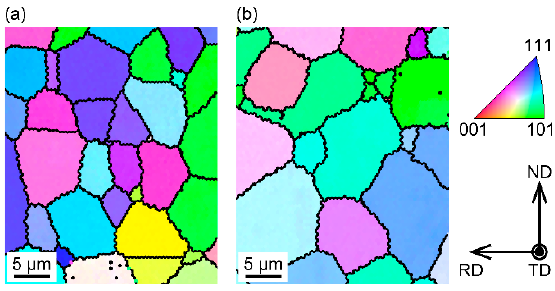
Figure 10. IPF maps of the chip specimens after heat treatment at 600 ◦ C for ( a ) 1 min and for ( b ) 5 min.